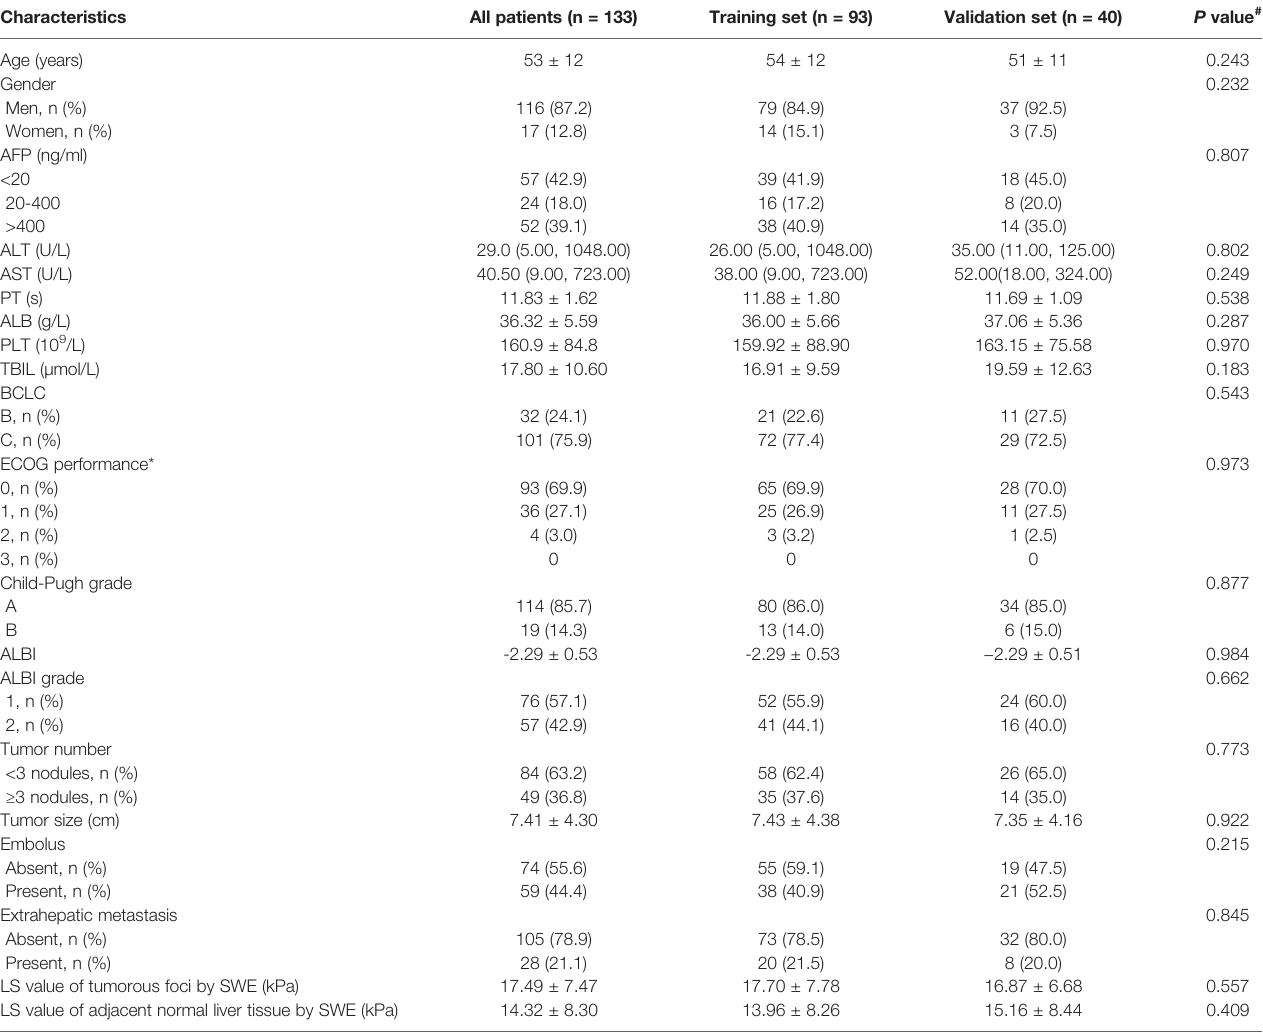
TABLE 1 | Baseline patient characteristics in the training and validation